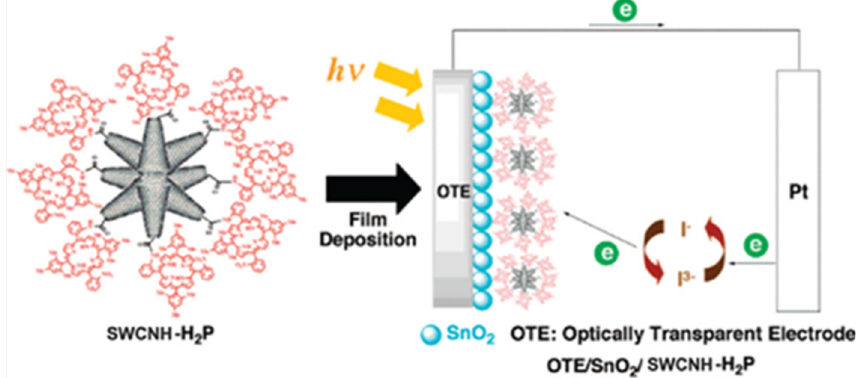
Figure 4. Schematic illustrations of SWCNH-H 2 P structure and a photoelectrochemical solar cell of OTE/SnO 2 /SWCNH-H 2 P. Reproduced with permission of [47]; American Chemical Society,